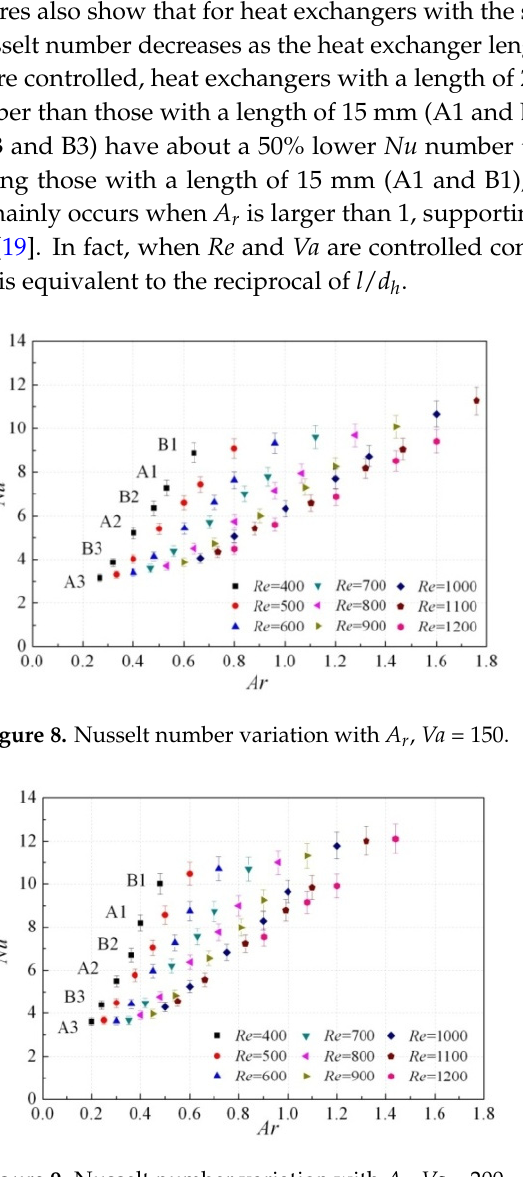
Figure 10. Nusselt number variation with A r , Va = 250.